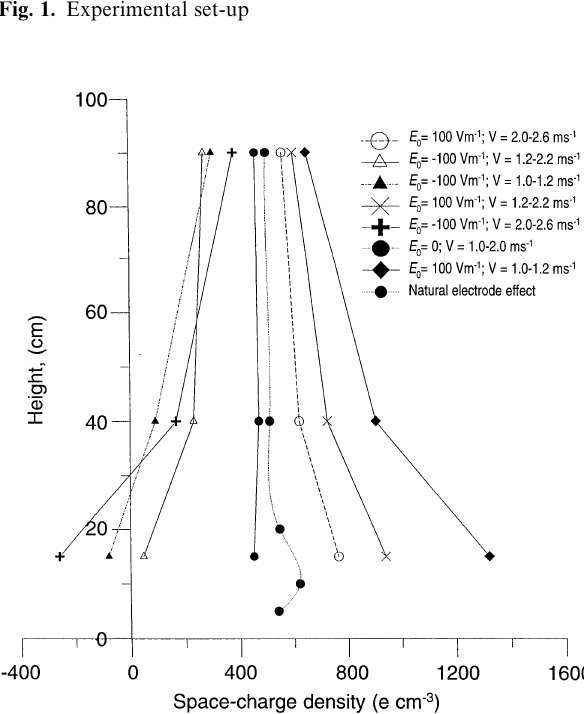
Fig. 2. Space-charge density profiles during different wind speeds and electric fields. The dotted curve represents measurements with- out the